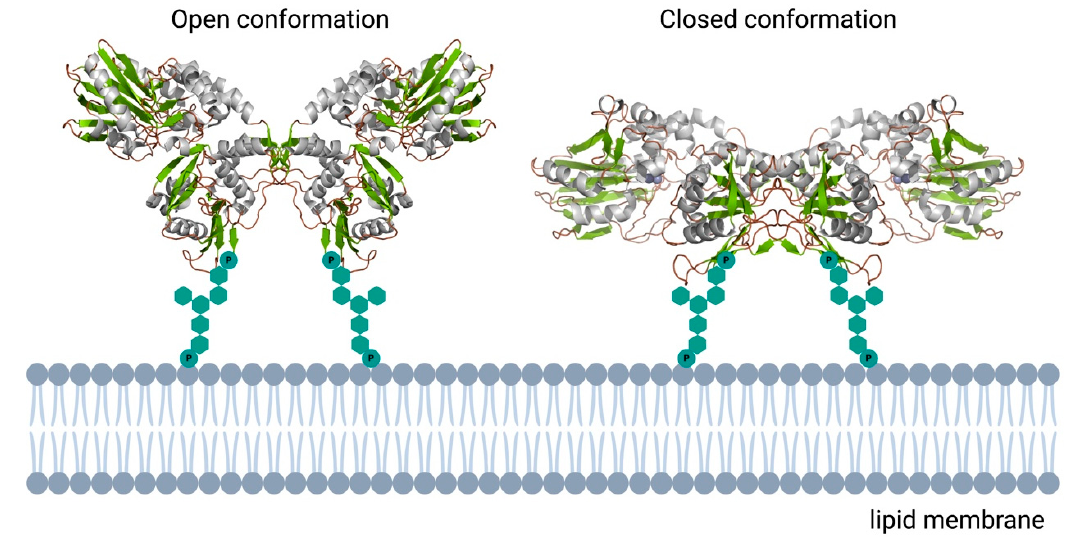
Figure 5. Schematic overview of the human ecto-5 ′ -nucleotidase. In contrast to the monomeric bacterial enzymes, eukaryotic e5NT exists and functions as a non-covalent homodimer. Open and closed conformations represented as reported in [73]. 3D structural cartoons of the Homo sapiens CD73 (PDB:4H2B and PDB:4H2I) [74,75] were rendered with PyMol and the figure compiled using BioRender.com [8].